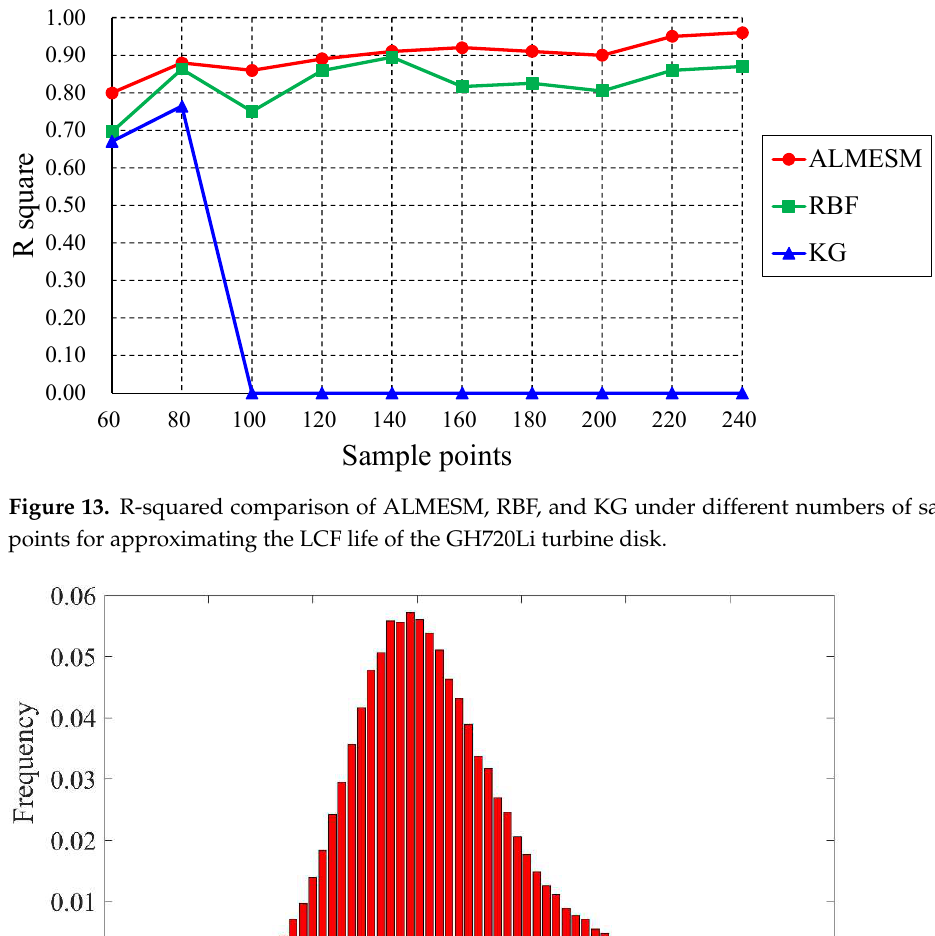
Figure 12. R-squared comparison of ALMESM and the original LME approximation with different globally unified  under different numbers of sample points for approximating the LCF life of the GH720Li turbine disk.